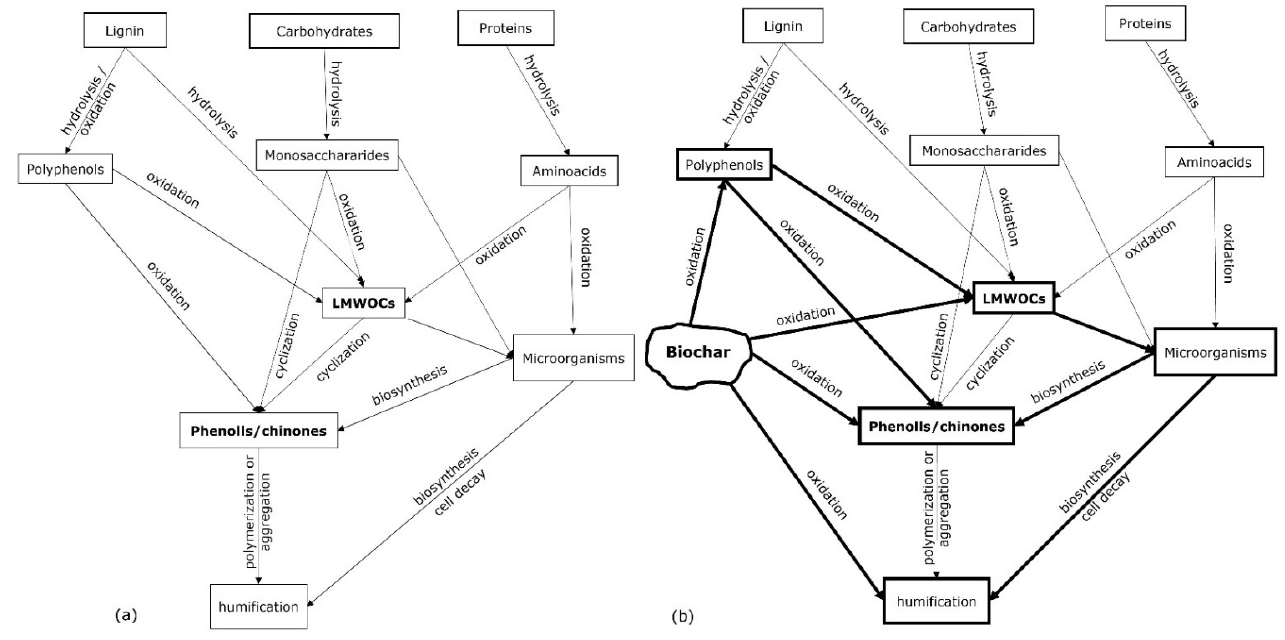
Figure 1. Organic matter decomposition in soil ( a ) and biochar decomposition in soil ( b ) processes mainly controlled by hydrolase and oxo-reductase enzymatic activities. The bold lines indicate the decomposition processes stimulated by the biochar amendment in soil. LMWCOs are the low molecular weight organic compounds.